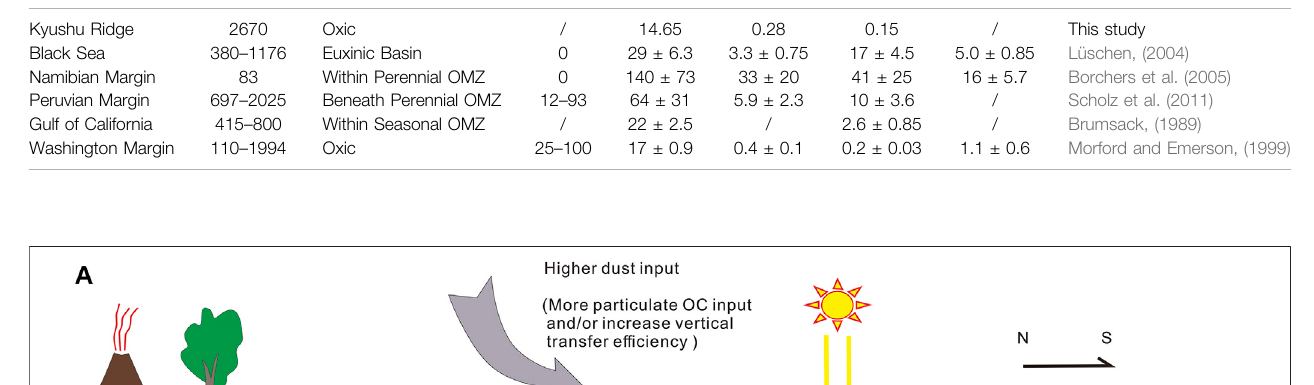
Frontiers in Earth Science |